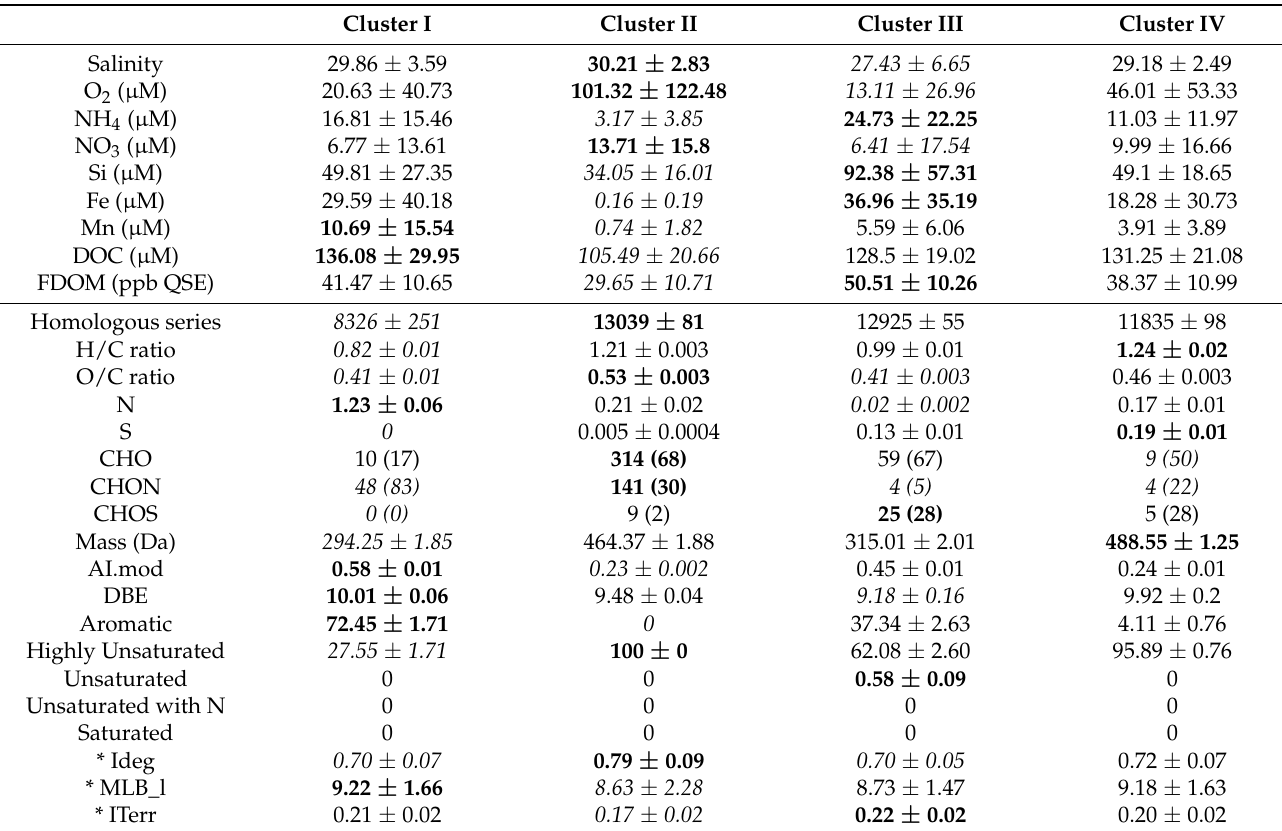
Table 1. Average ( ± standard deviation) concentrations of environmental parameters and relative abundances of DOM molecular characteristics for the four clusters. DOM molecular data were derived from intensity weighted means of molecular formulae with a p adj < 0.05 (depicted in van Krevelen plot). The highest value of each parameter amongst the four clusters is in bold and the lowest in italic. Wilcoxson pairwise comparisons between the clusters were performed for each category; the results are included in Supplementary Table